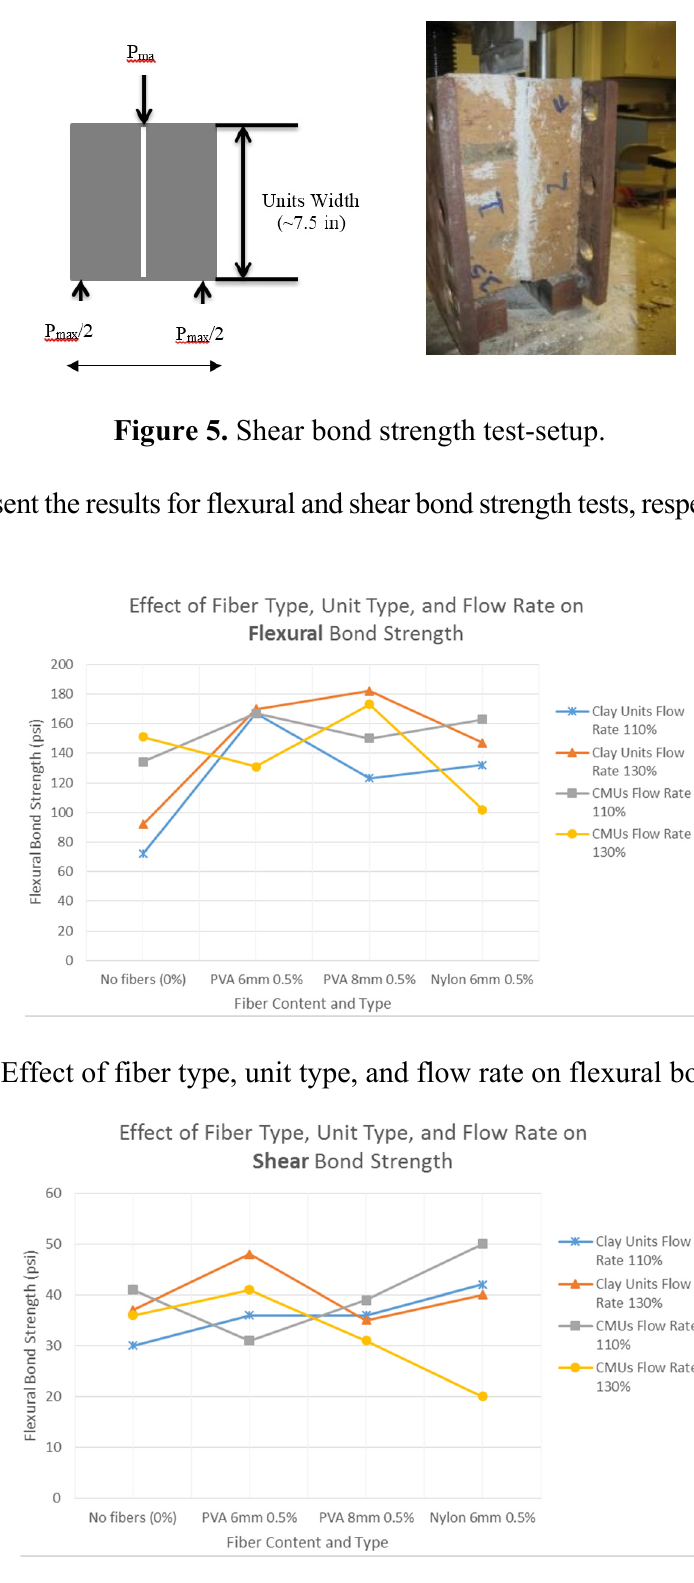
Figure 7. Effect of fiber type, unit type, and flow rate on shear bond